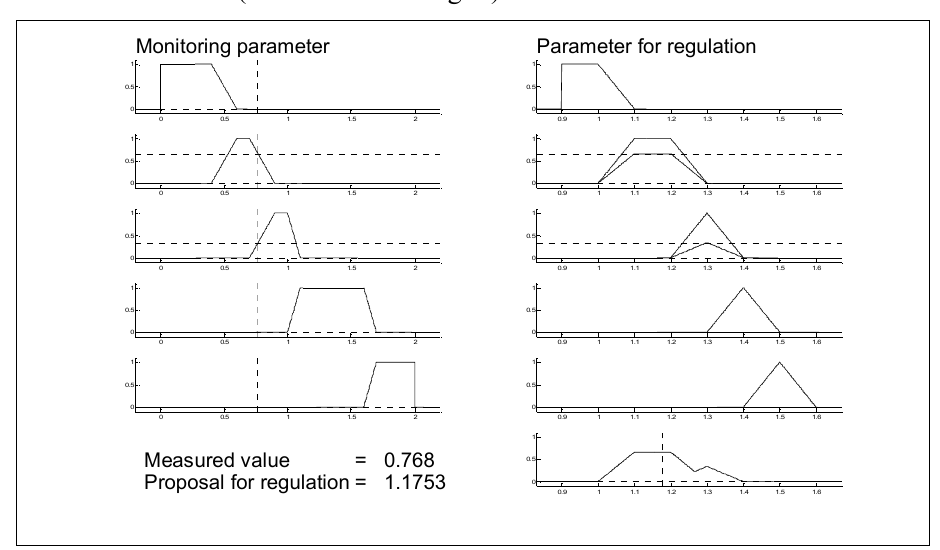
Figure 3 – Graphical depiction of the calculation of